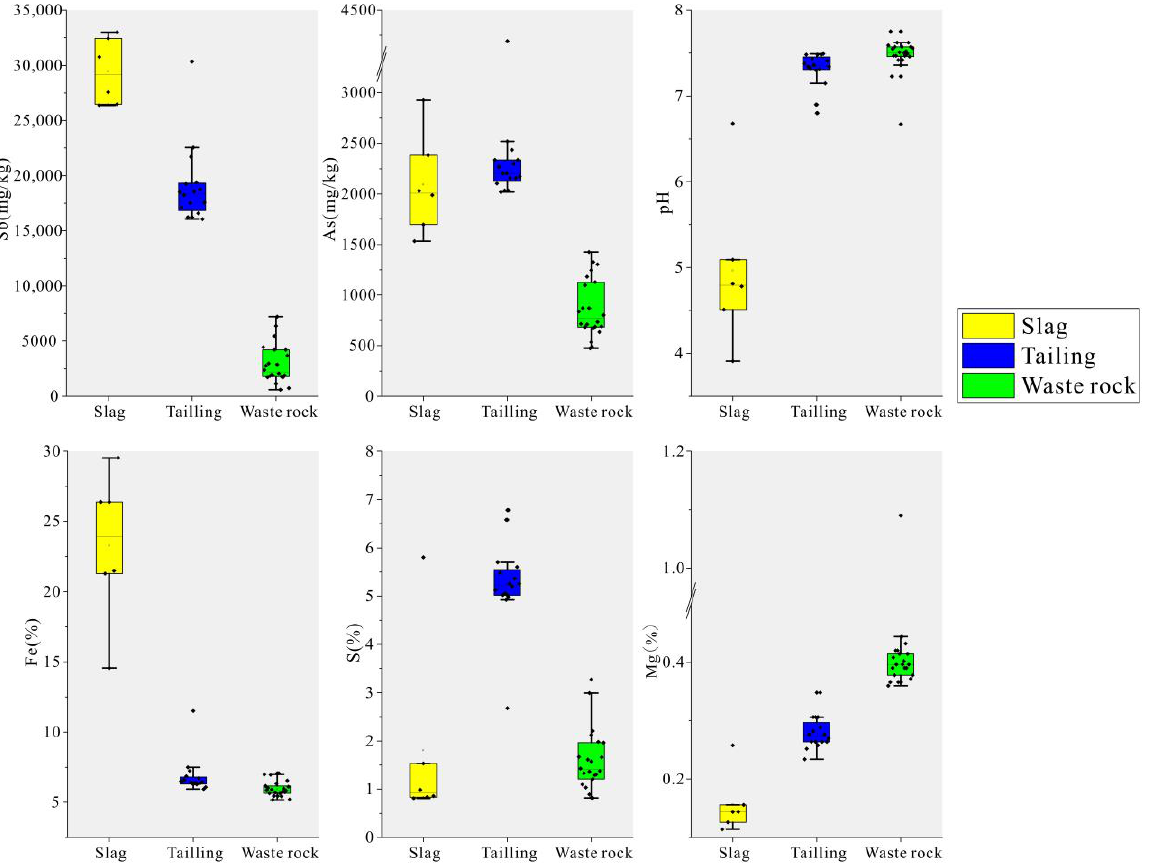
Figure 2. Box line diagram of geochemical parameters of three mine wastes.